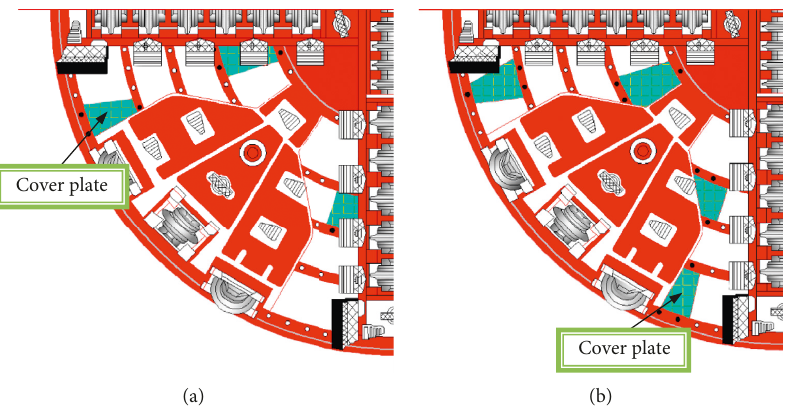
Figure 8: Diagram showing the adjusting device that controls the opening rate and position of the cutter head.